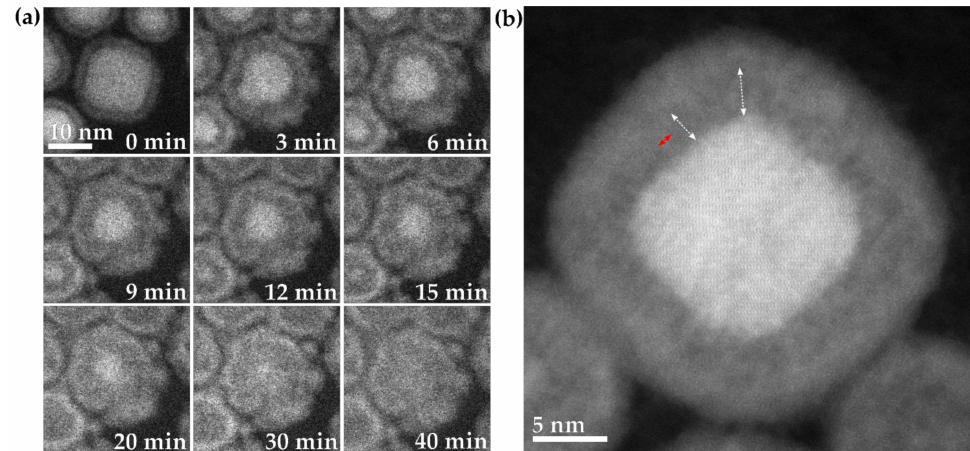
Figure 7. ( a ) In situ visualization and analysis of dynamic oxidation of a nanocube of Fe 2 C in HAADF-ESTEM at 200 ◦ C with 2 Pa oxygen. ( b ) High-resolution HAADF-STEM image of a partially oxidized nanocube of Fe 2 C@Fe x O y , with the white double-sided arrows indicating the void section and the red double-sided arrow indicating the bridge material.